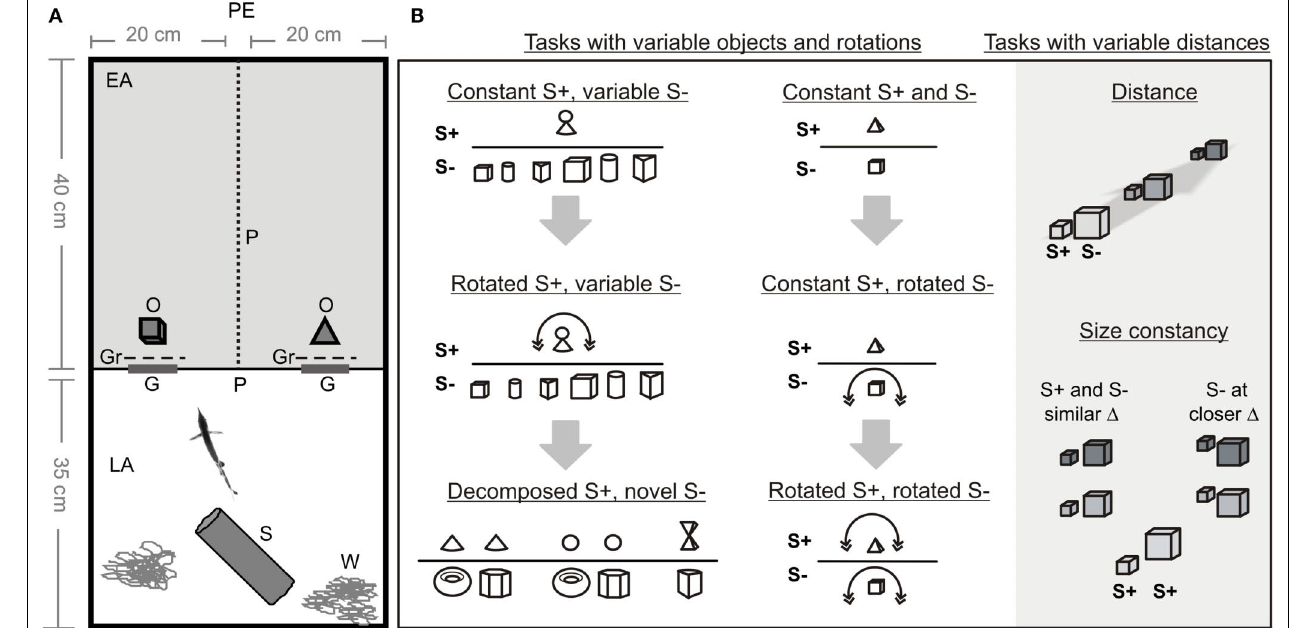
trained either with constant S + and variable S − (left column) or constant S + and constant S − (right columns). In the tests, S + and/or S − were rotated, changed in their distances from the gates, or new S − were